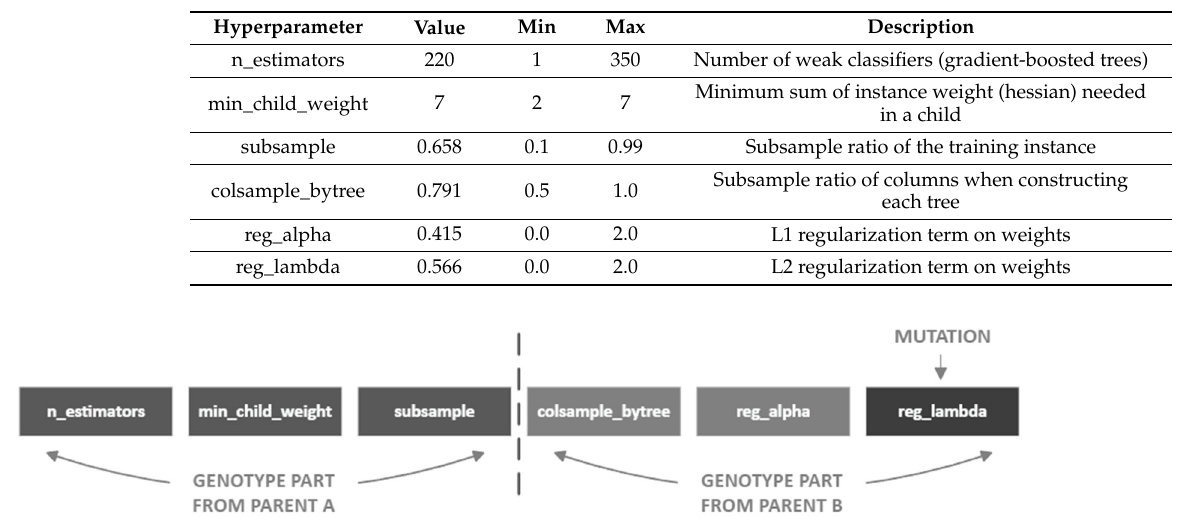
Table 1. XGBoost classifier hyperparameters optimized with the use of a genetic algorithm.